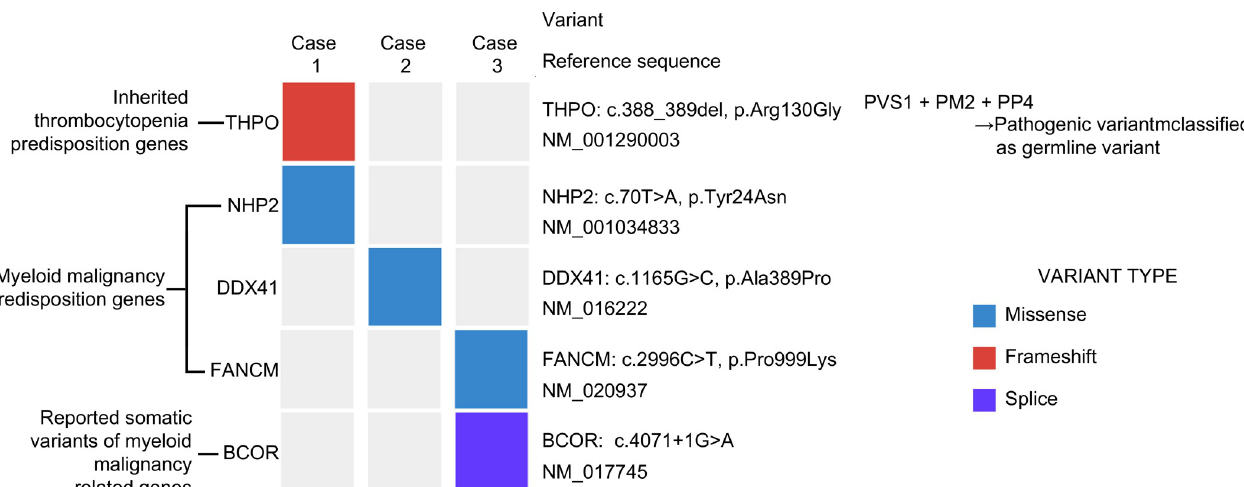
PLOS ONE | https://doi.org/10.1371/journal.pone.0271624 December19,